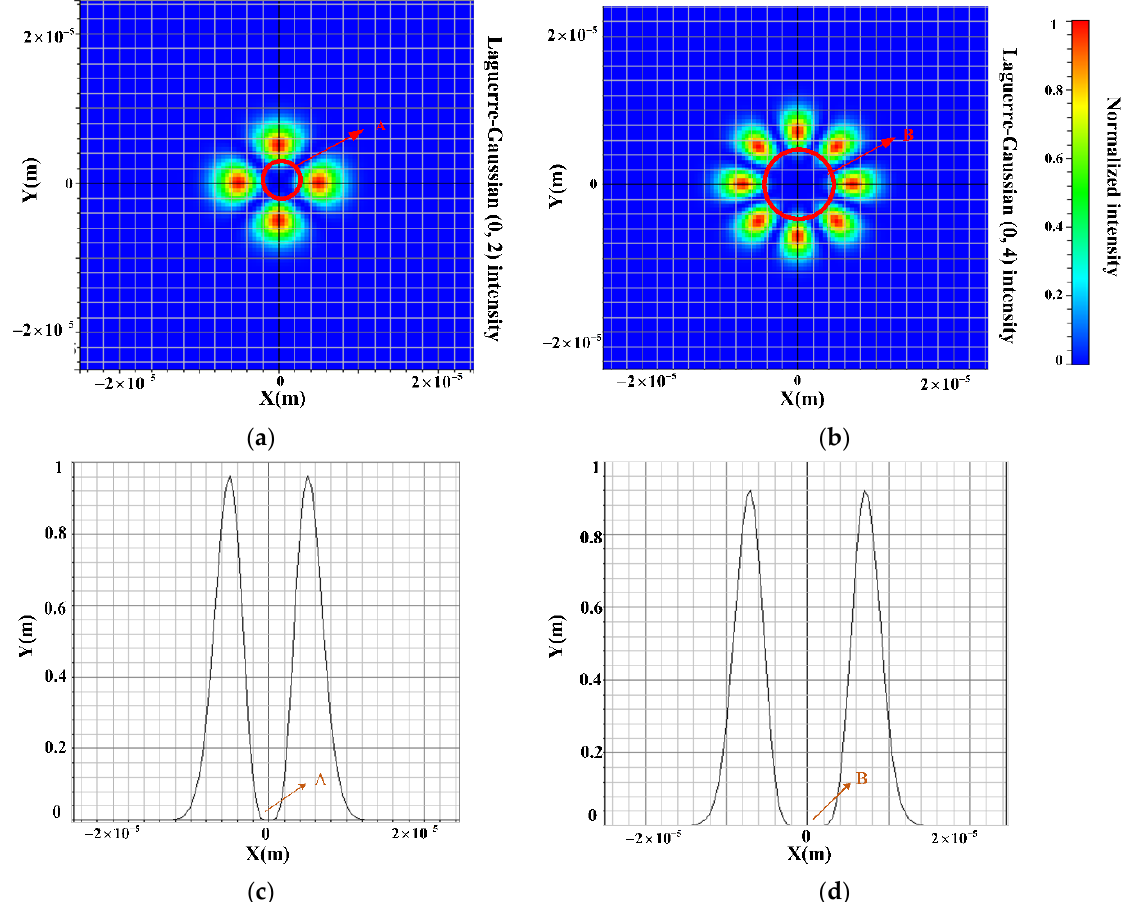
Figure 3. 3-Dimension and 2-Dimension transverse electric field intensity of the ( a , c ) LG l = 0, p = 2 ; mode. A, B: optical zero vortex radius. ( b , d ) LG l = 0, p = 4 mode. A, B: optical zero vortex